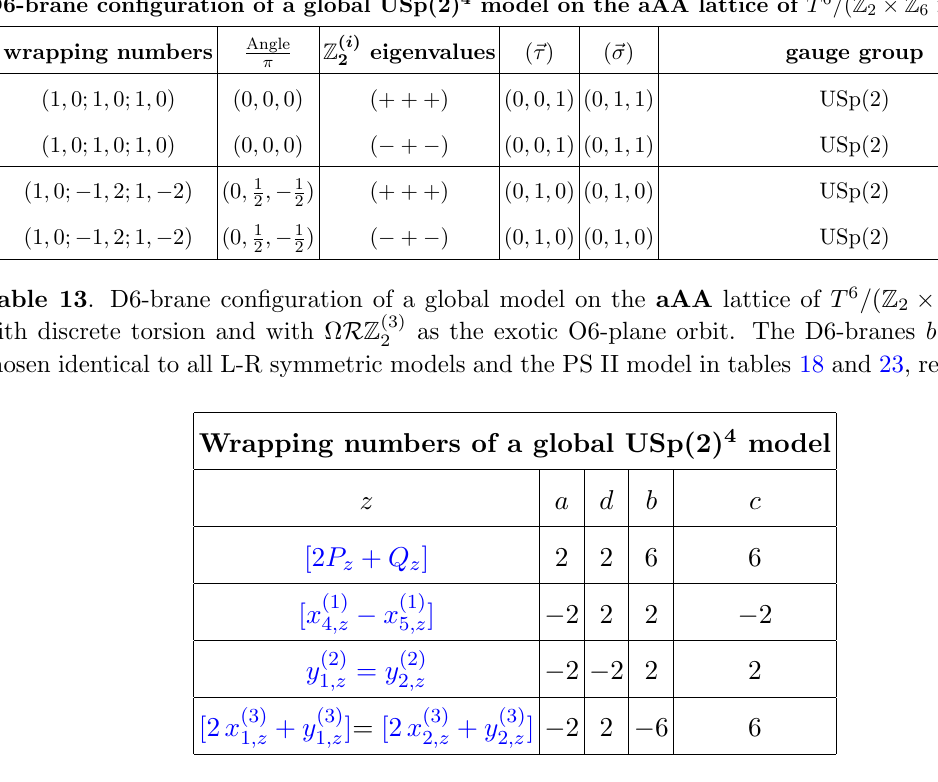
Table 14 . Non-vanishing wrapping numbers of the global USp(2) 4 model with D6-brane data speci(cid:12)ed in table 13. The Z 2 (cid:2) Z 2 eigenvalues are chosen such that the D6-branes b and c agree with those of all L-R symmetric models and the PS II model, cf. table